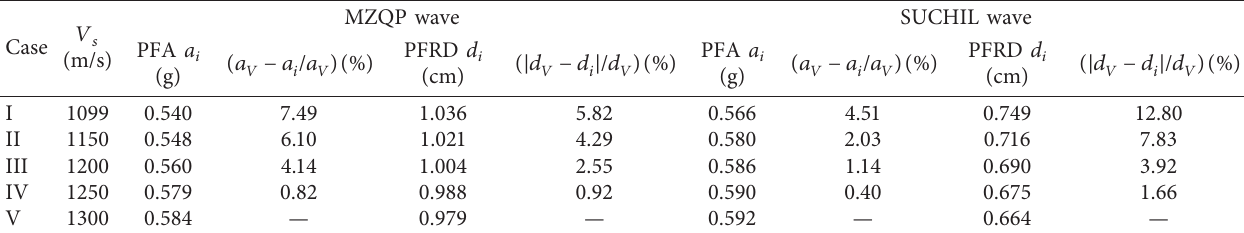
Table 8: PFA and PFRD at the top of the